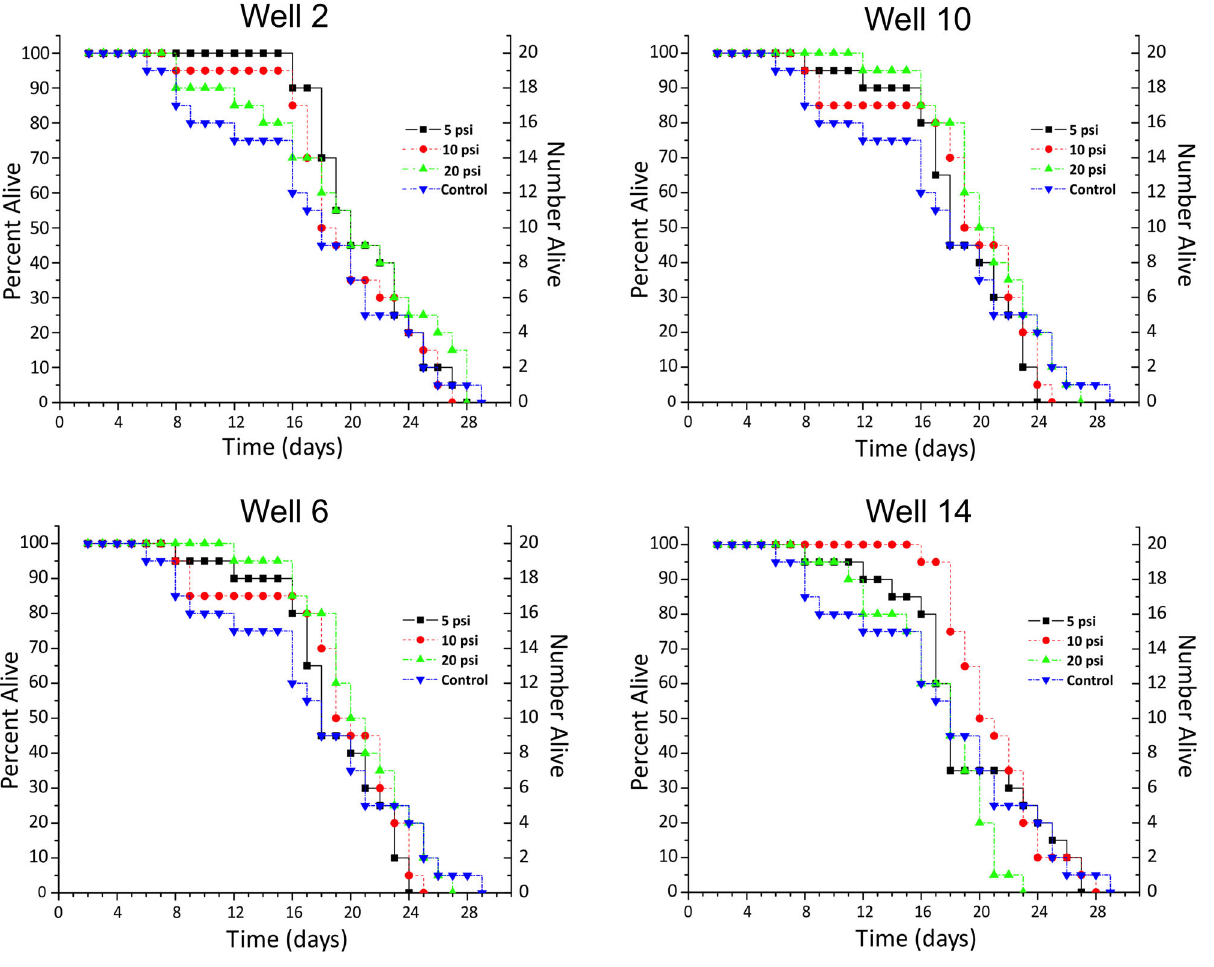
Figure 5. Worm viability test. The daily change in live worm population numbers for 3 different applied pressures to the gasket relative to control in four representative wells; each well resides in a different column of the